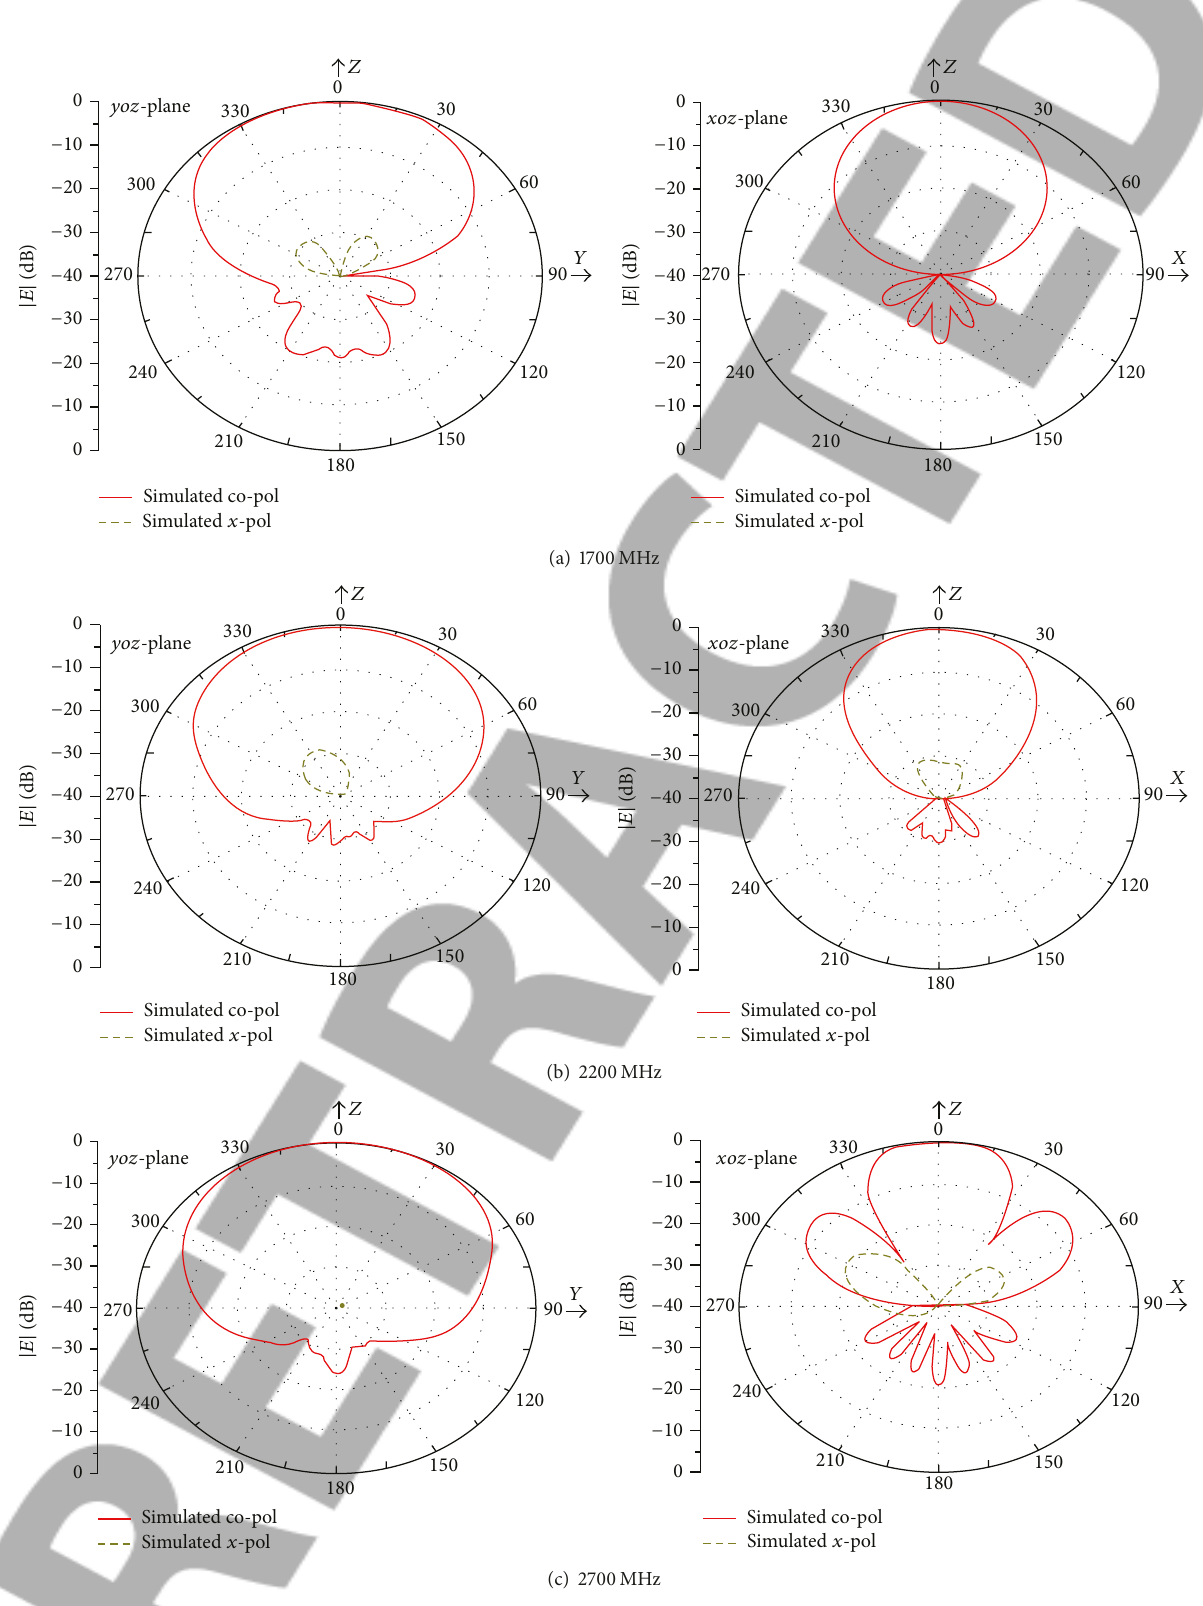
Figure 4: Simulation results of the radiation pattern of the